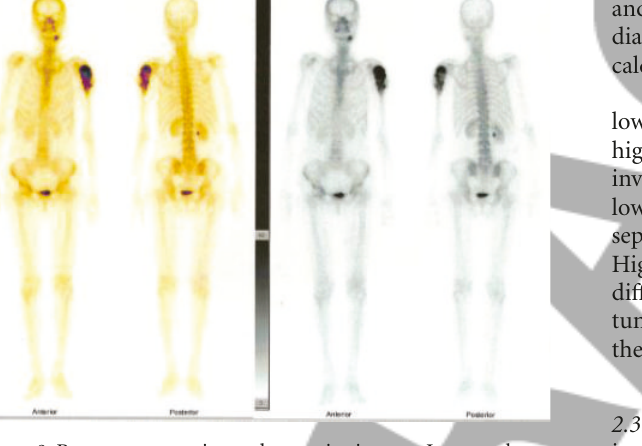
Figure 9: Bone scan: anterior and posterior images. Increased tracer uptake in the lesion.